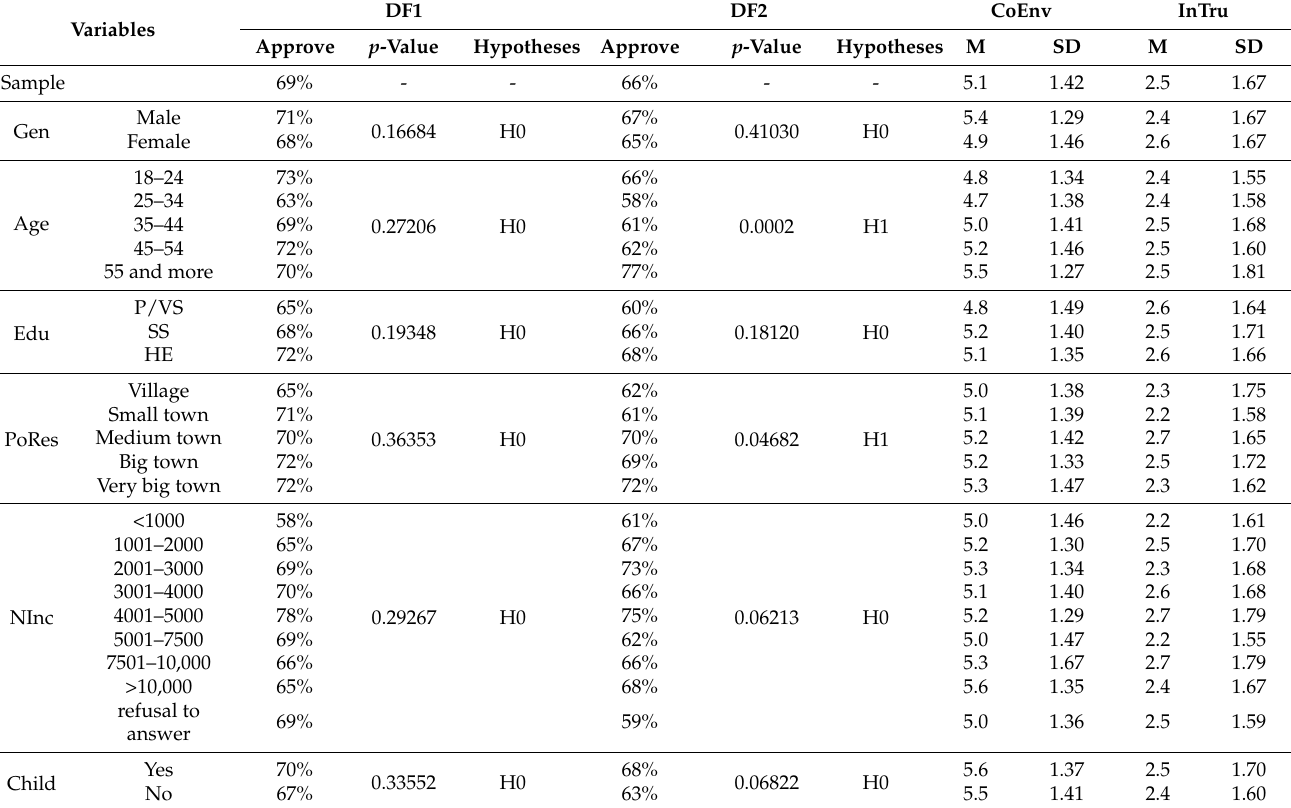
Table 4. Results: demographic